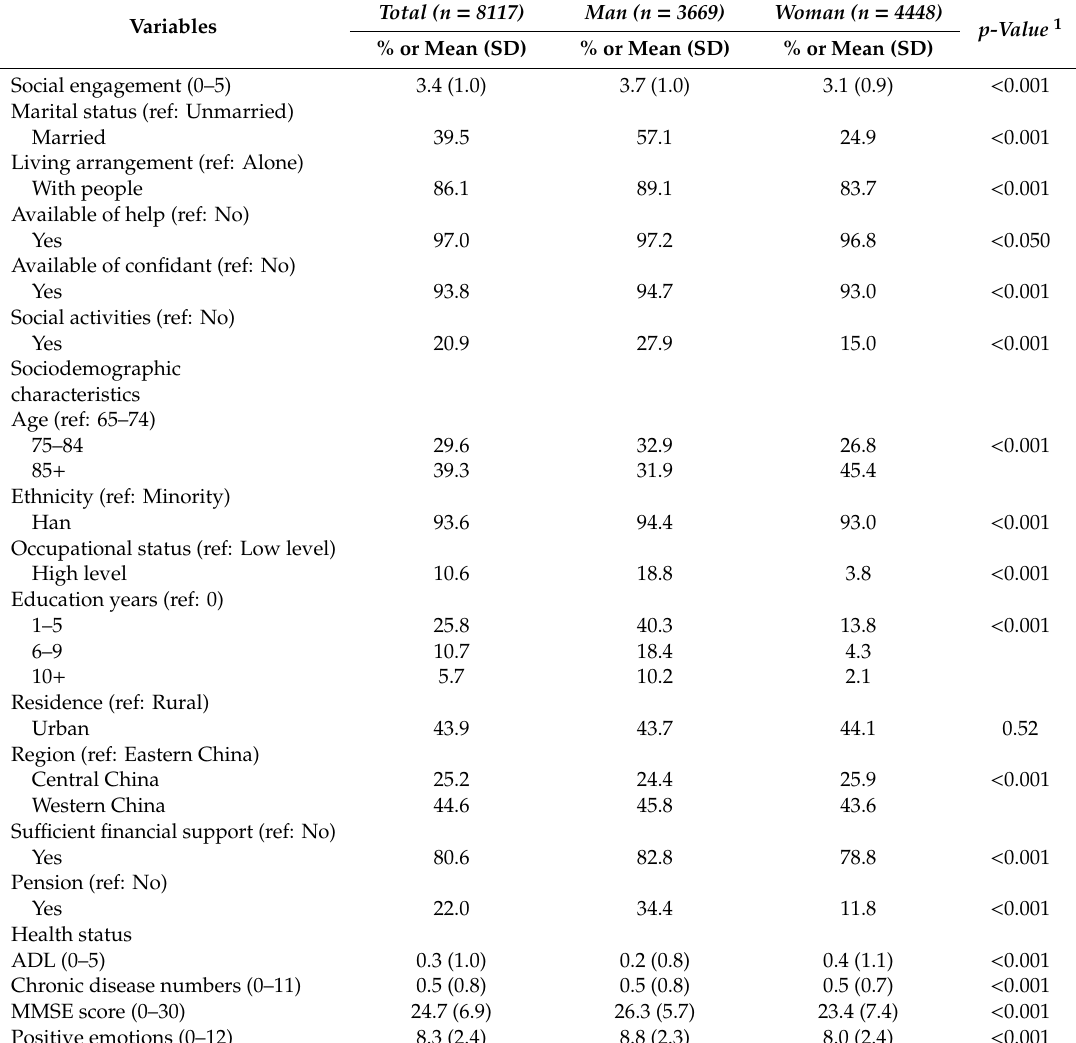
Table 1. Baseline characteristics of older adults and their sex di ff